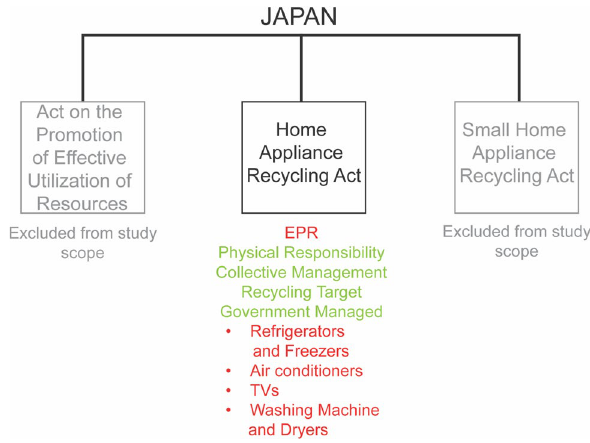
Fig. 1 Relevant WEEE regula- tion systems: Japan—synthe- sized by